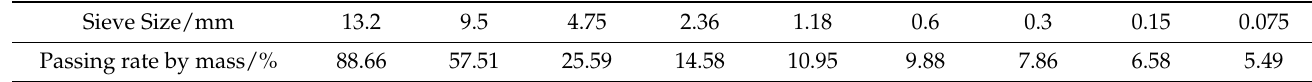
Table 2. Aggregate composite